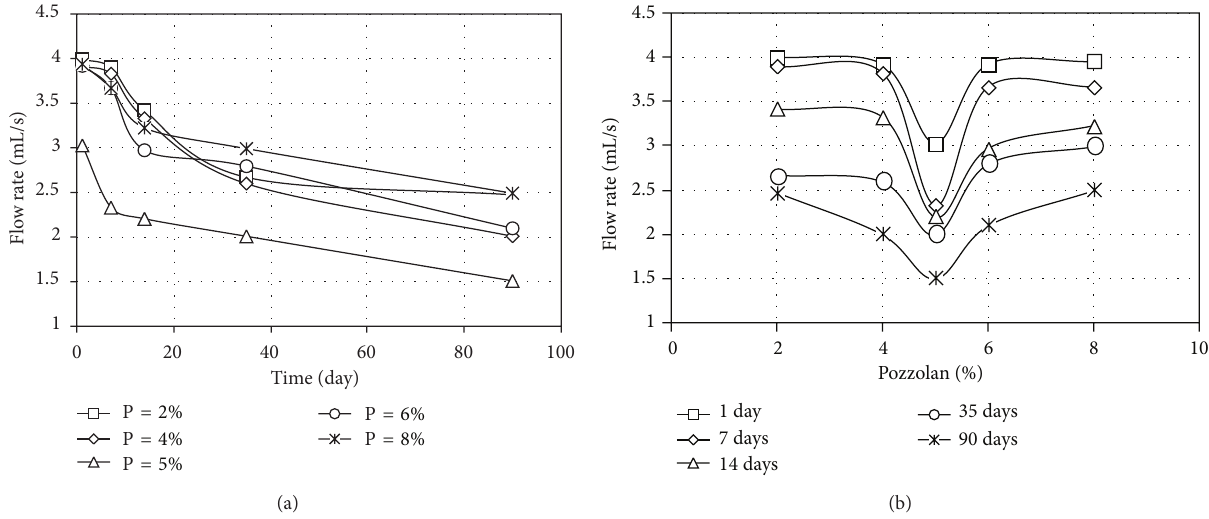
Figure 3: Flow rate for treated samples (a) of different pozzolan contents and (b) of different curing times, for different pozzolan contents. 0.511.522.533.54